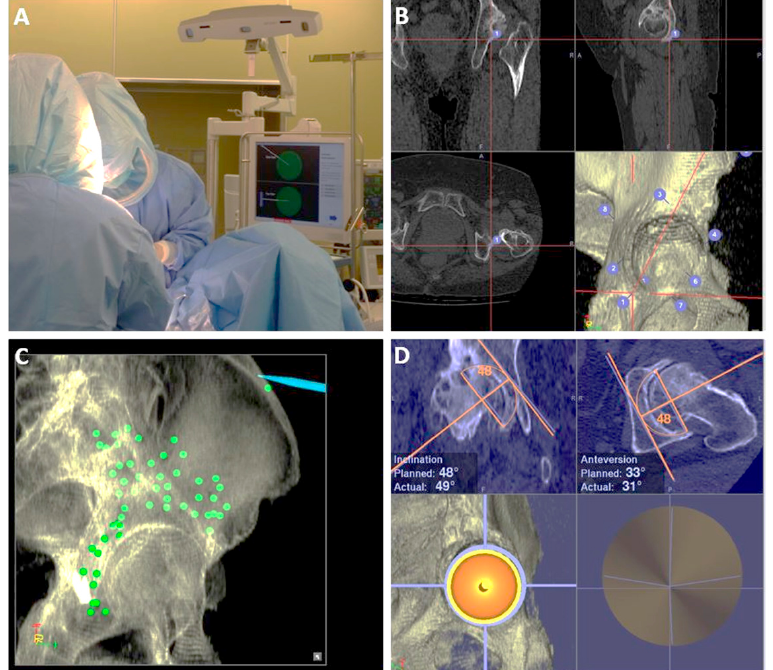
Figure 2. Intraoperative picture of CT-navi. ( A ) An overall picture of the CT-navigation system during the surgery. ( B ) Initial paired-point matching registration by touching several bony landmarks. ( C ) Surface matching of the pelvis by digitizing many points around the acetabulum and the ilium. ( D ) Cup placement during the surgery. Both the planned and actual angles are displayed.